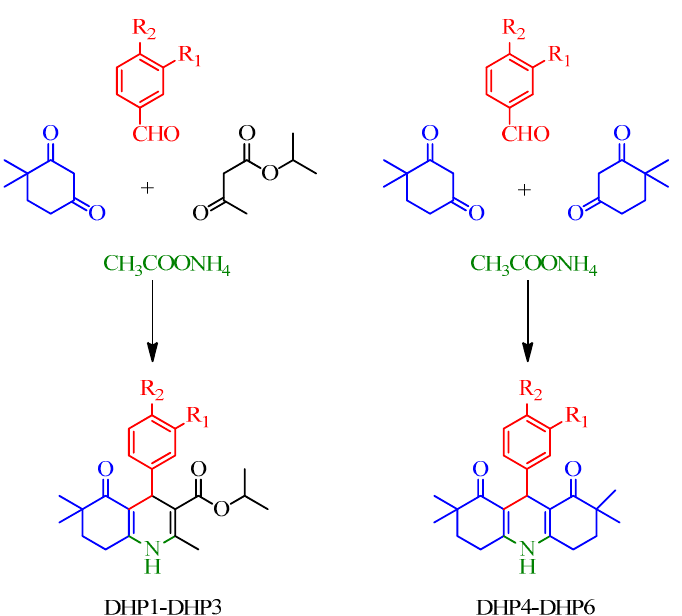
Figure 2. Synthetic scheme for the preparation of DHP-based compounds.